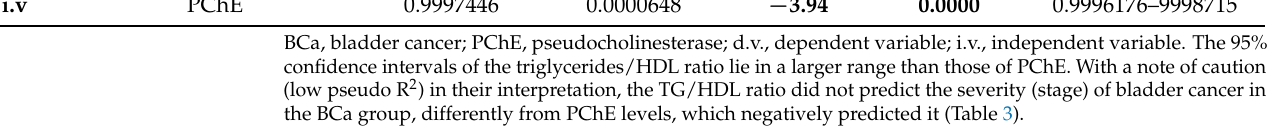
Table 3. Prediction of the staging of bladder cancer by the triglycerides/HDL ratio and pseudo- cholinesterase